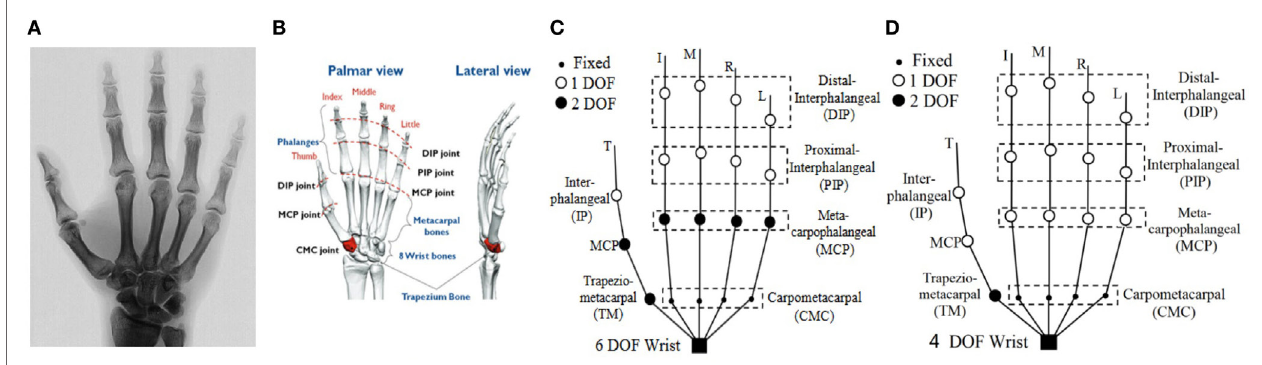
FigUre 4 | Bones in human hand (a,B) (Agur and Dalley, 2009), hand’s degree of freedoms (DOF) (c) (Magnenat Thalmann et al., 2017), and mechanical model of our robotic hand (20 DOFs) (D) (Magnenat Thalmann et al.,